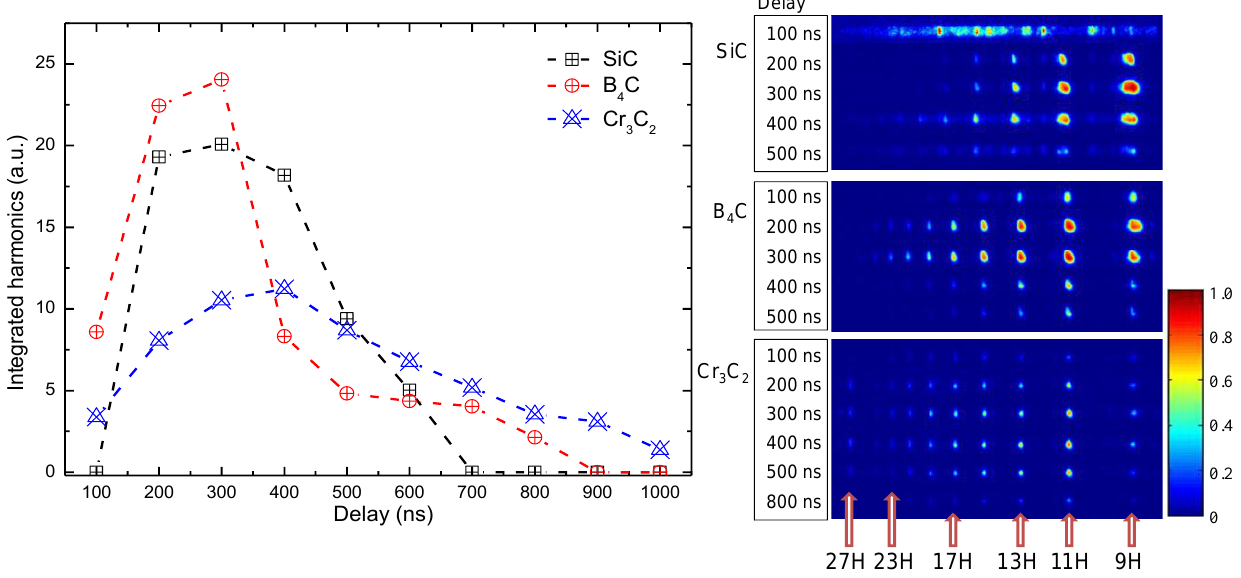
Figure 4. Integrated harmonics dependency on delay between HP NS and PP. Left panel presents dependency plot for integrated HHG signal for SiC NPs (black squares), B 4 C NPs (red circles), and Cr 3 C 2 NPs (blue triangles). The right panel shows a few raw spectra of harmonics for the delays from 100 ns to 500 ns (SiC and B 4 C) and for Cr 3 C 2 from 100 ns to 500 ns, but the last row presents HHG spectrum at 800 ns. Bottom numbers (9H – 27H) correspond to the harmonic orders.